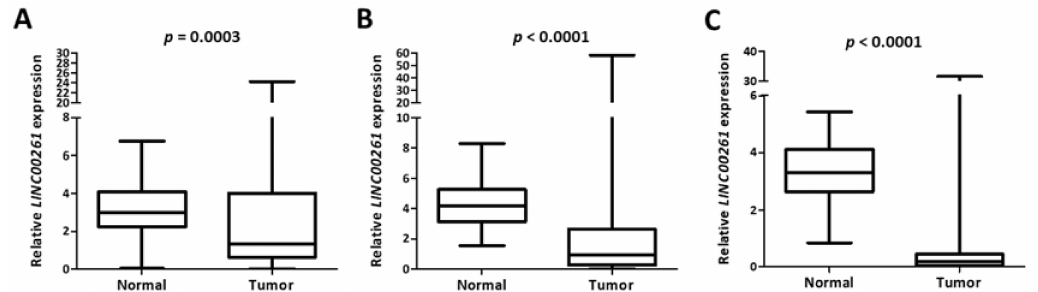
Figure 2. LINC00261 is suppressed in lung cancer. ( A – C ) The LINC00261 expression data from LUAD-Korea ( n = 77 normal/83 tumor). ( A ) LUAD-TCGA ( n = 55 normal/486 tumor) and ( B ) lung squamous cell carcinoma (LUSC)-TCGA ( n = 17 normal/220 tumor). ( C ) Datasets are represented as box